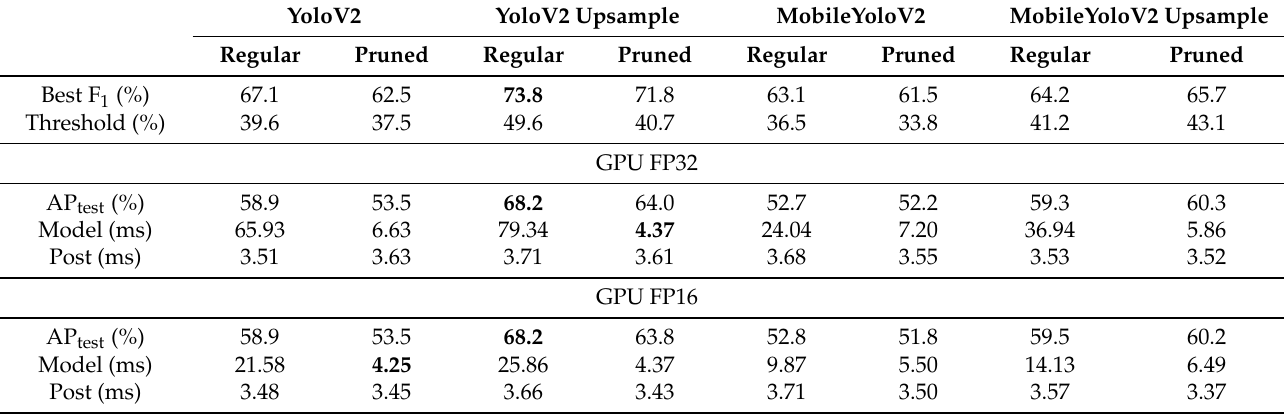
Table 8. Model accuracy and inference times measured on the NVidia Jetson Xavier and averaged over the LWIR test set. AP is measured with a threshold of 1% and timing results are measured with a threshold set at the best F1 score. The best values are shown in